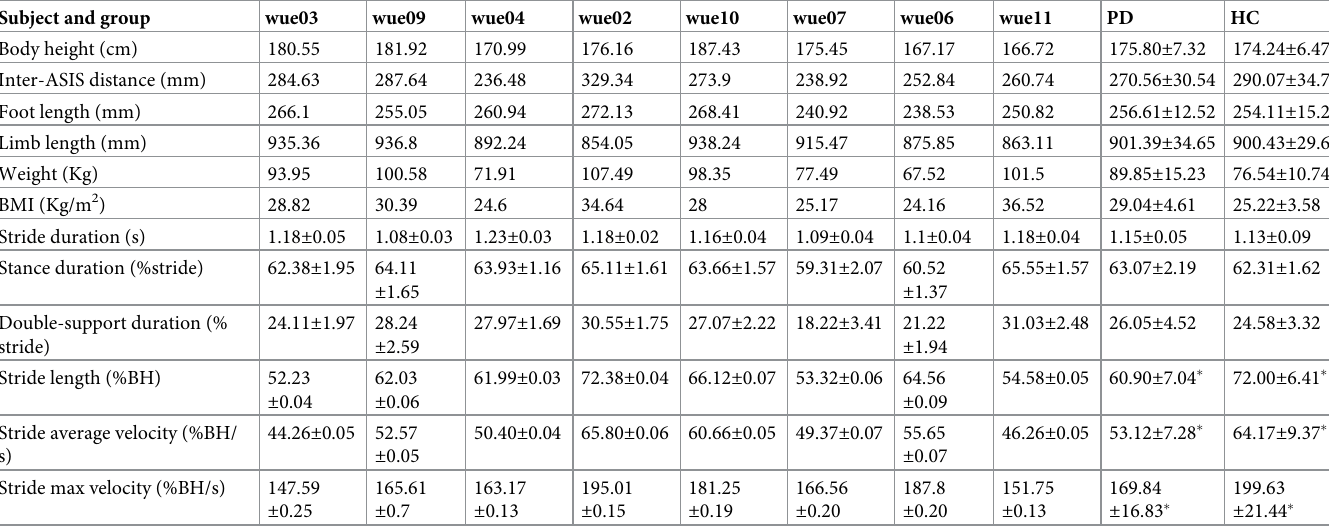
Table 2. Anthropometric and kinematic data.